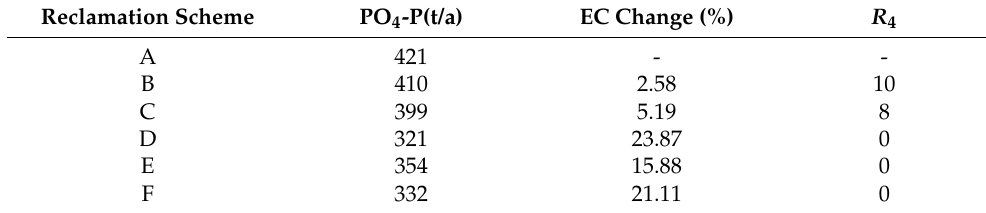
Table 15. Feasibility evaluation in PO 4 -P environmental